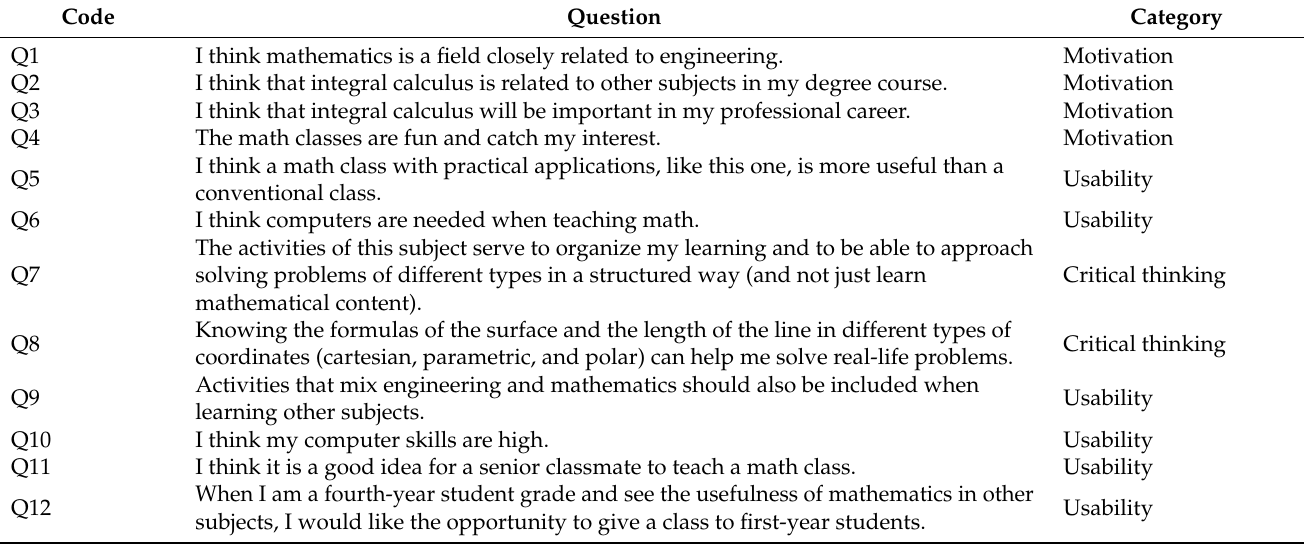
Table 2. All questions included in the questionnaire with a Likert scale.